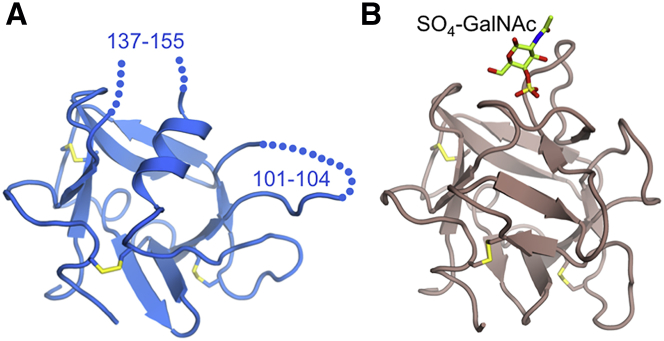
Comparison of the Ricin-like Domains of Endo180 and MRThe ricin-like domains of (A) Endo180 and (B) MR (Liu et al., 2000) are shown in the same orientation. The disordered loop regions in Endo180 are indicated by dotted lines. The 4-SO4-GalNAc molecule bound to MR is shown in atomic detail.